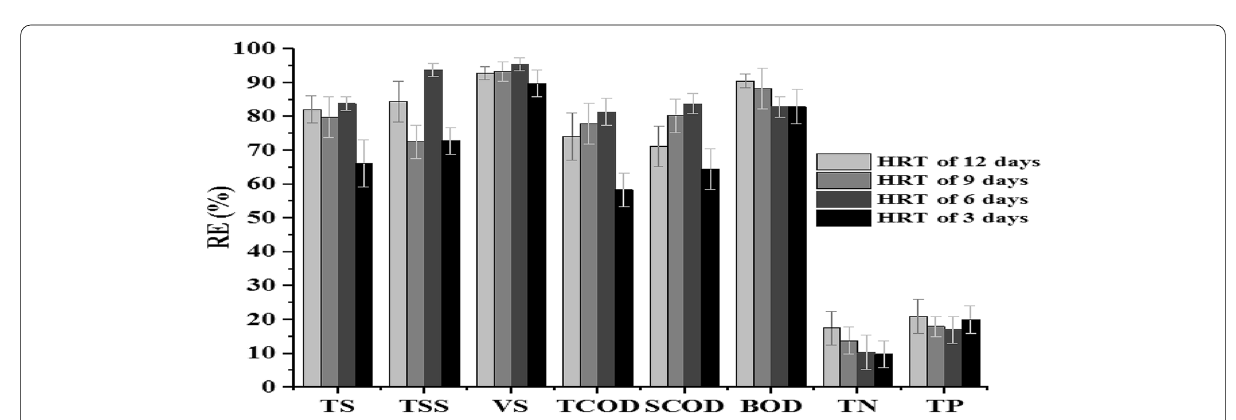
Fig. 6 Organic matter, TN, and TP removal efficiency of methanogenesis